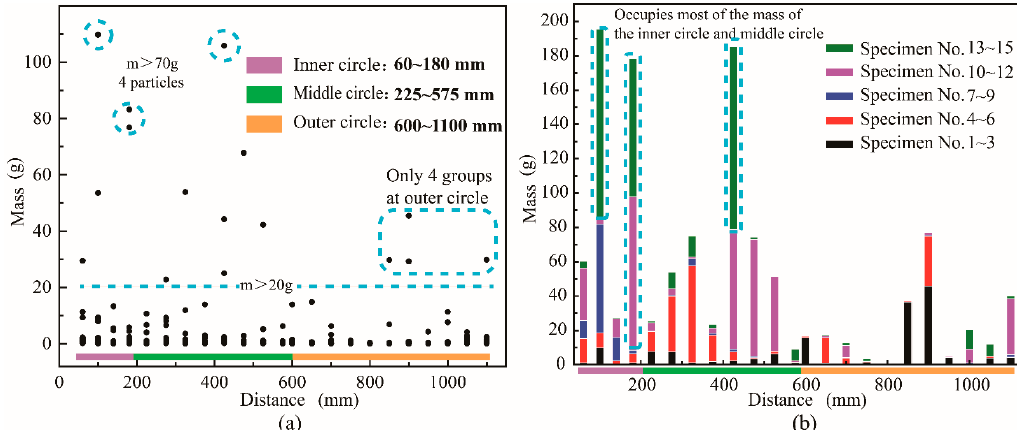
Figure 12. Spatial distribution characteristics of large particles. ( a ) Scatter plot of particle spatial distribution ( b ) Summary of particle spatial distribution of each group.